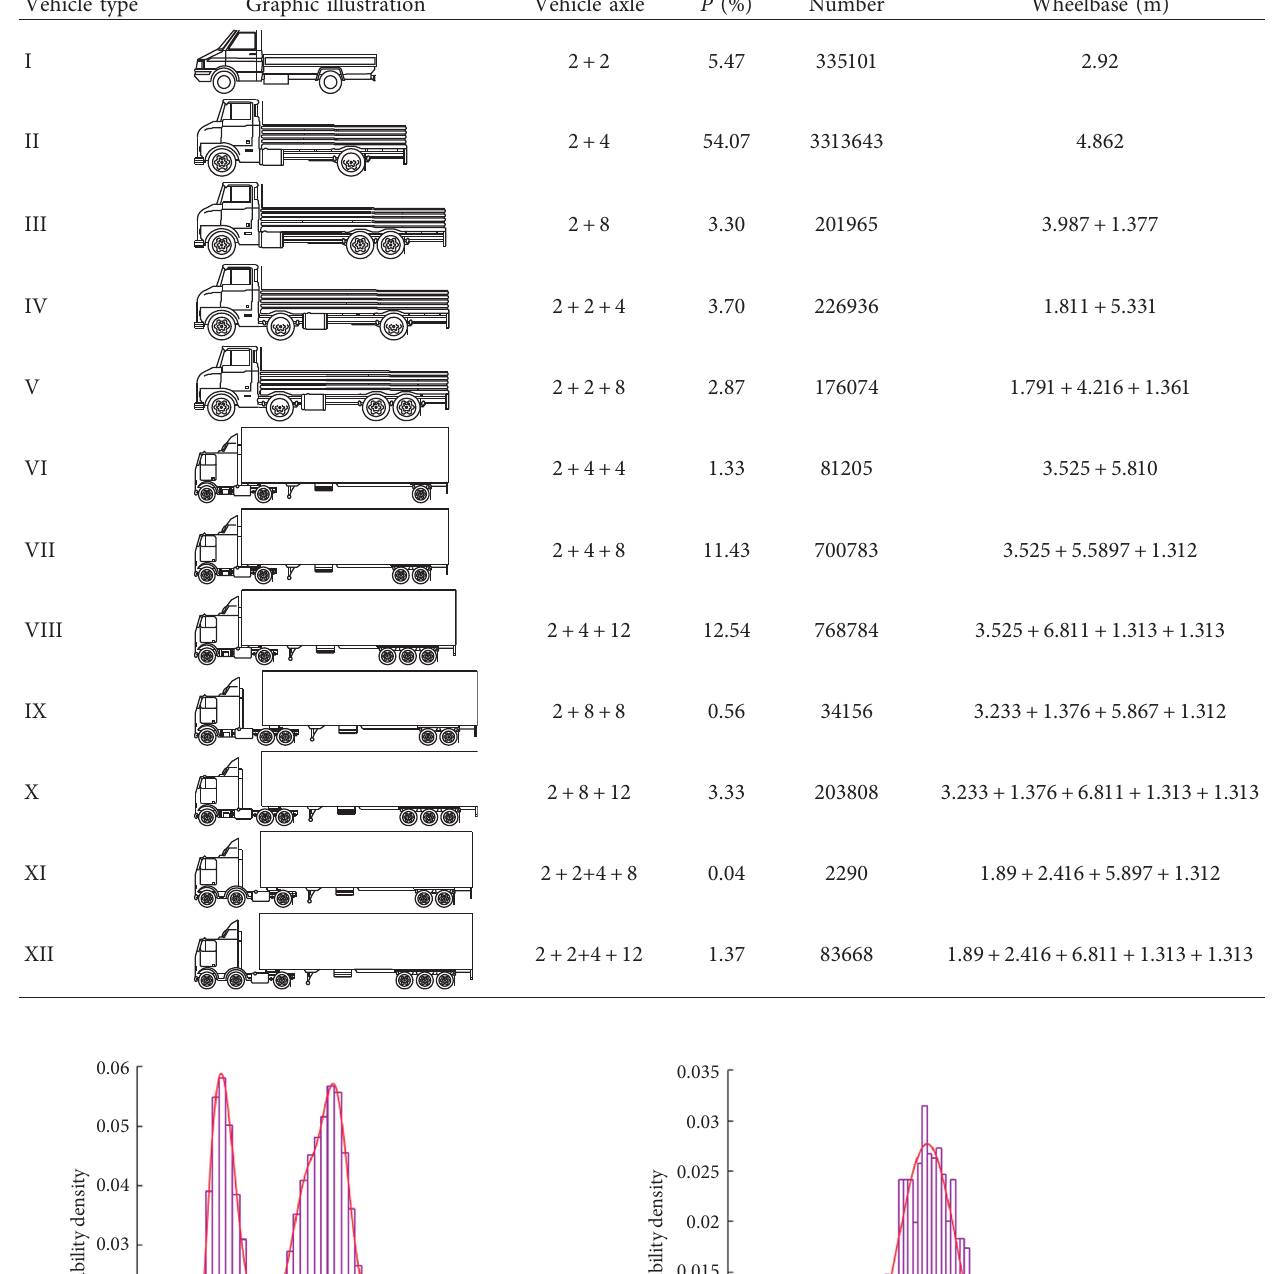
Table 1: Vehicle types and associated